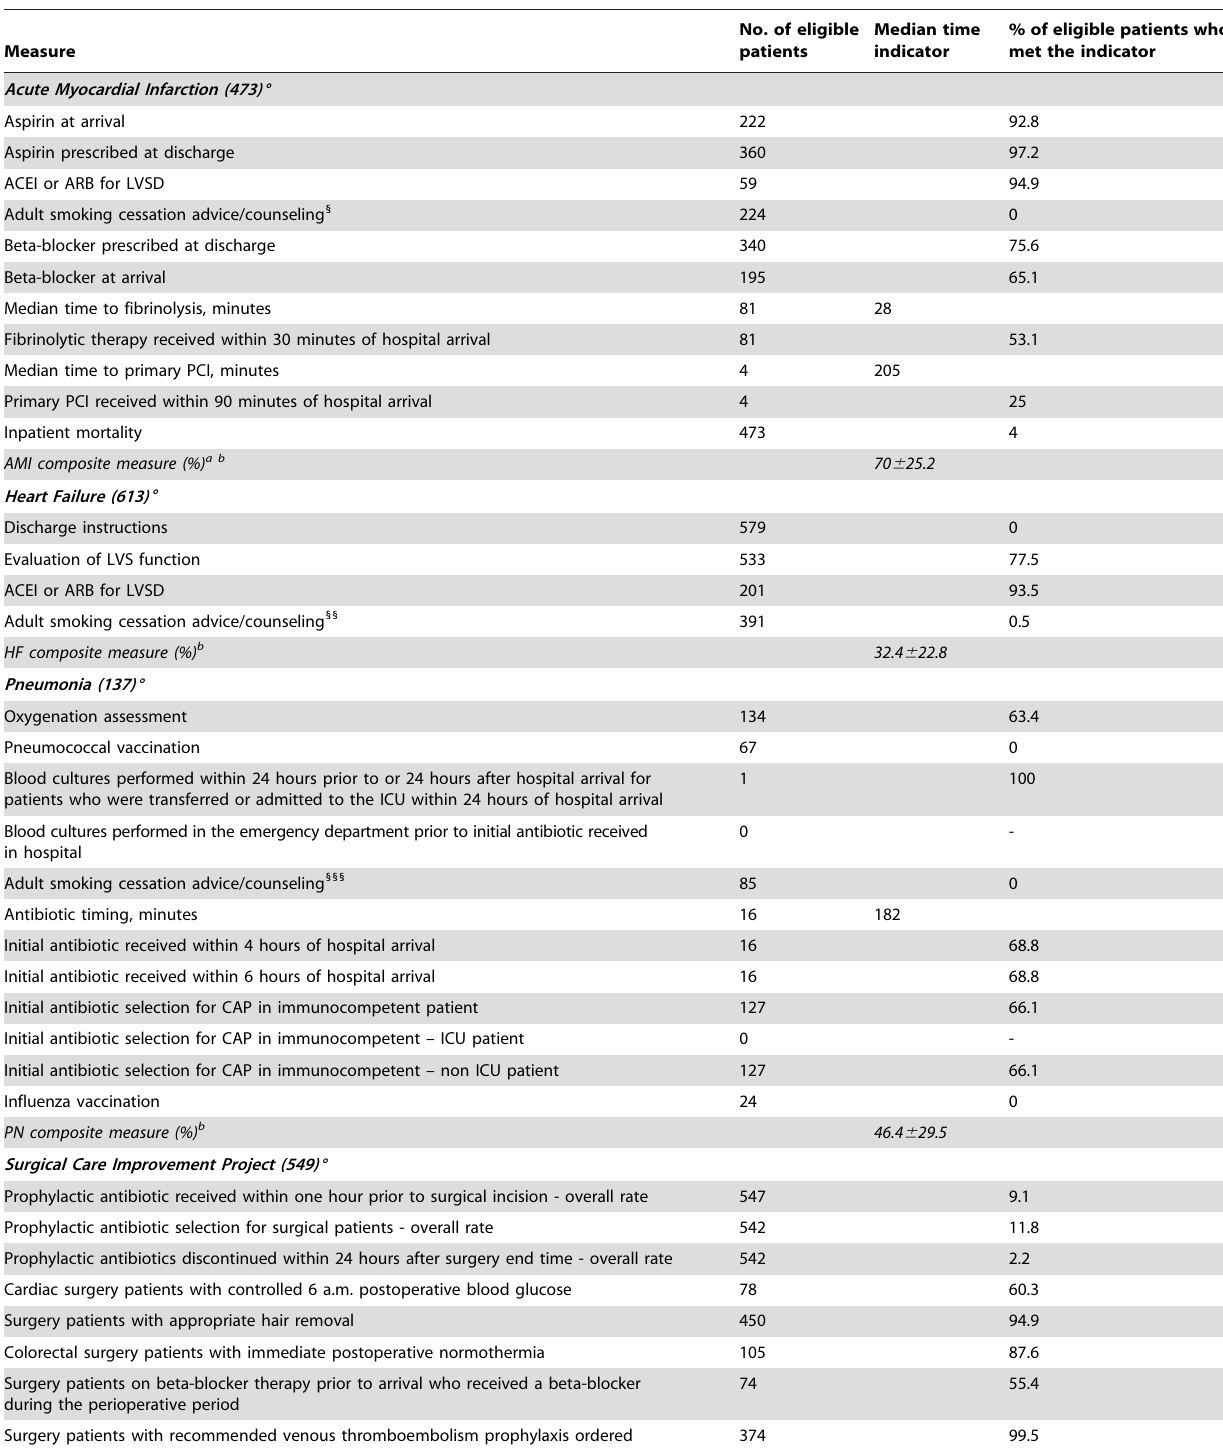
Table 2. Frequency distribution of quality measures